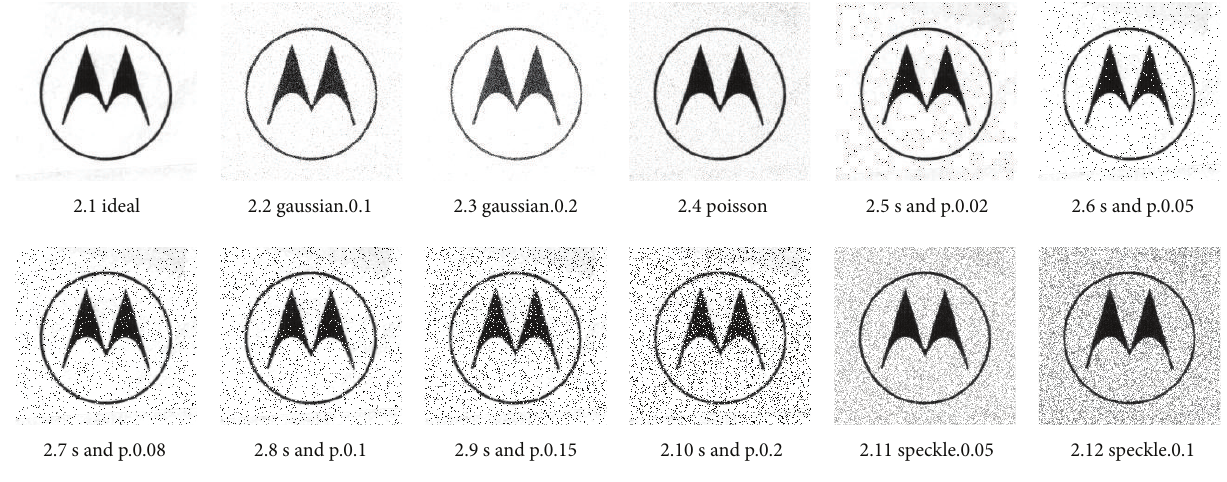
Figure 2: Logos with different noise.